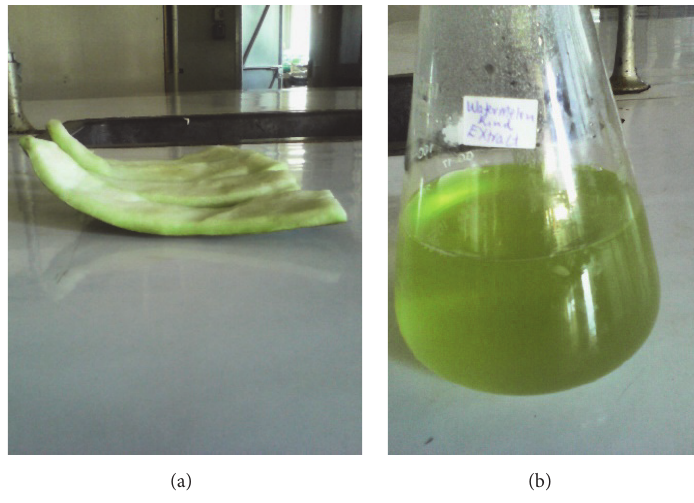
Figure 1: (a) Watermelon rind. (b) Watermelon rind